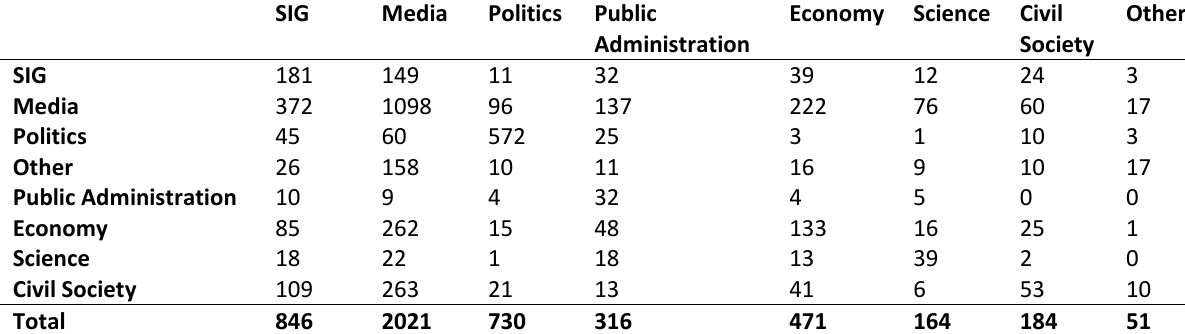
Table 1. Links from social field to social field.